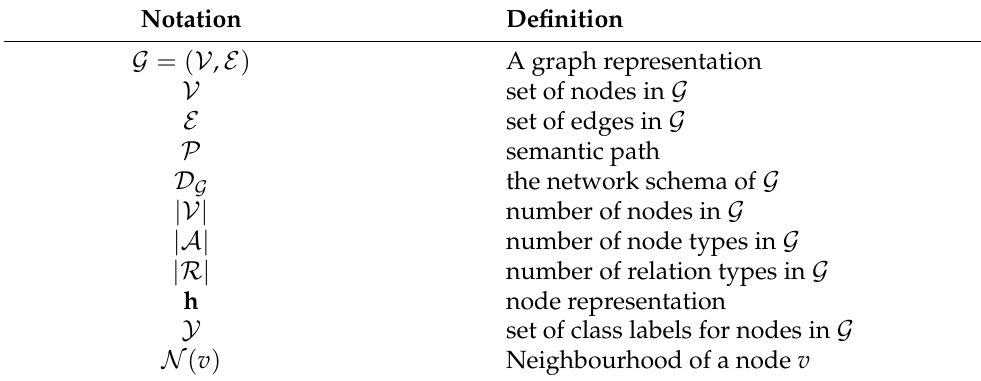
Table 1. Notations and